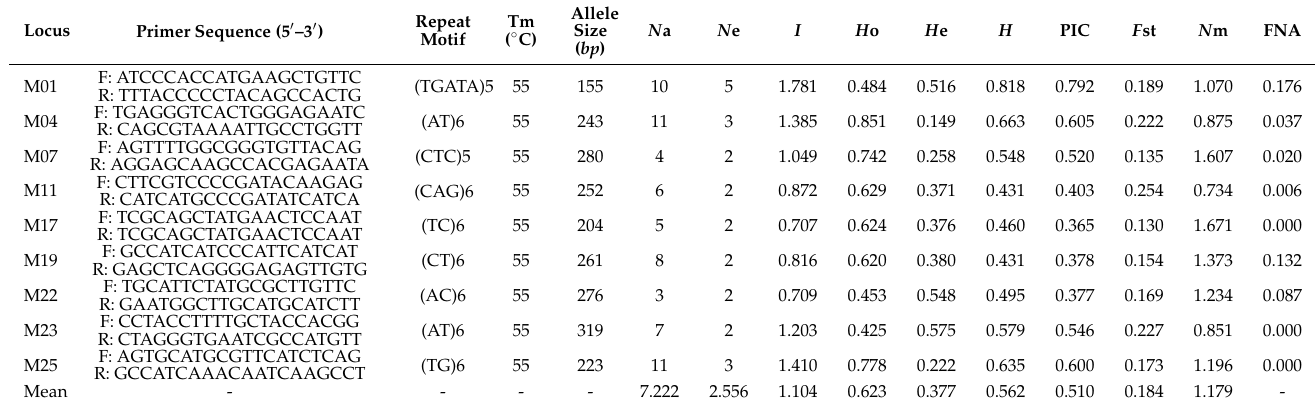
Table 2. Information on nine nSSR loci used for PCR amplification and diversity estimates in the analysis of genetic diversity.